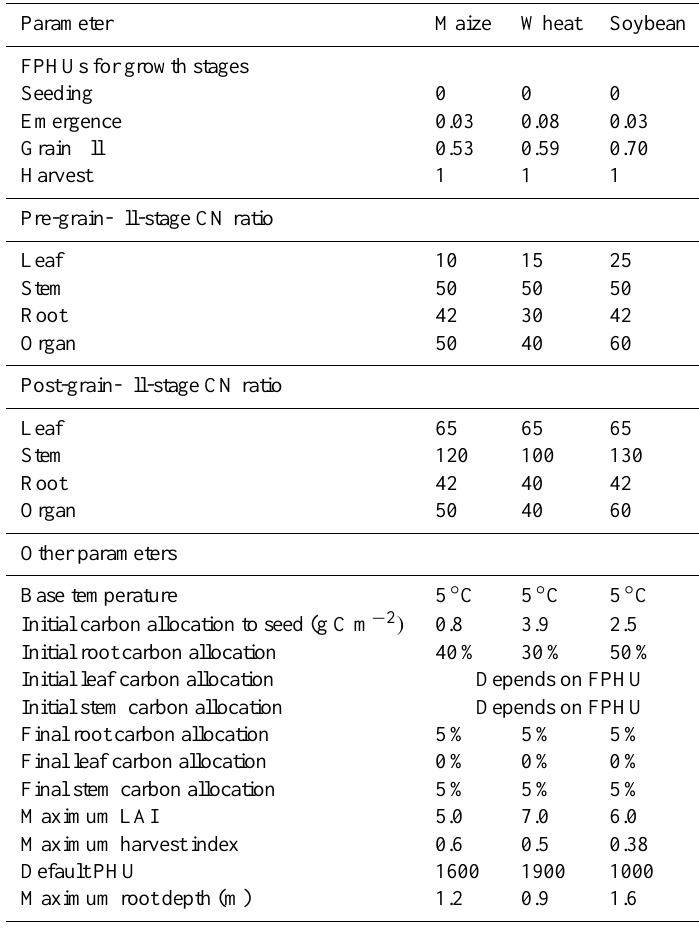
Table 1. Crop parameters. Parameter Maize Wheat Soybean FPHUs for growth stages Seeding 0 0 0 Emergence Grain